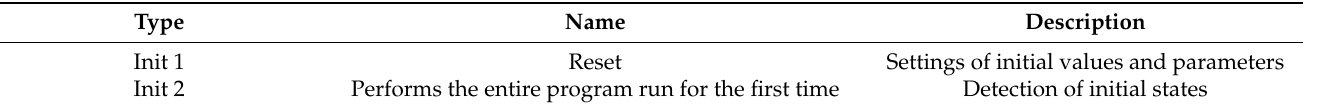
Table 4. Init function of IIoT device.